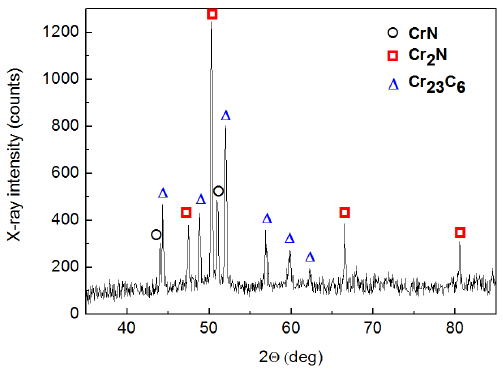
Figure 7. XRD spectrum of the precipitates extracted from the steel heat treated 2 h at 800 °C.